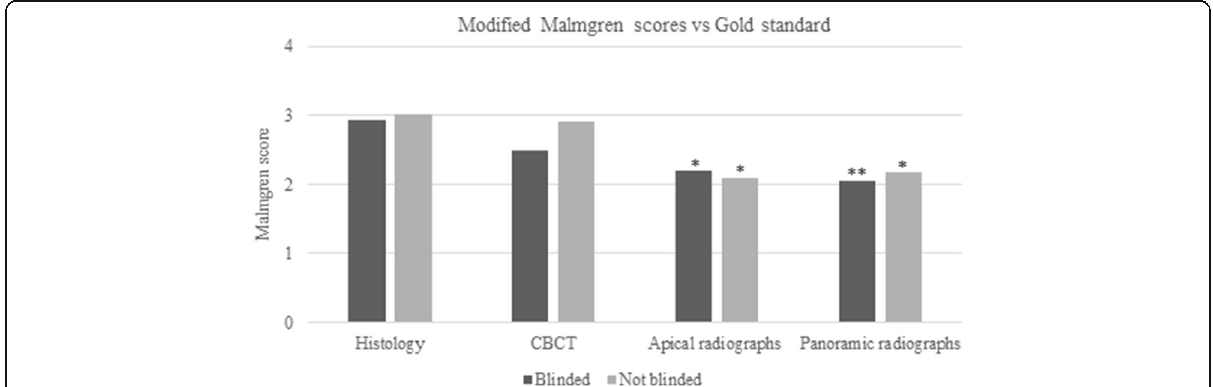
Fig. 5 Modified Malmgren scores for CBCT, periapical radiographs (PA), and panoramic radiographs (PAN) versus gold standard (histology). PA and PAN differed significantly in both blinded ( p < 0.05 and < 0.001 respectively) and not blinded ( p < 0.05) compared to